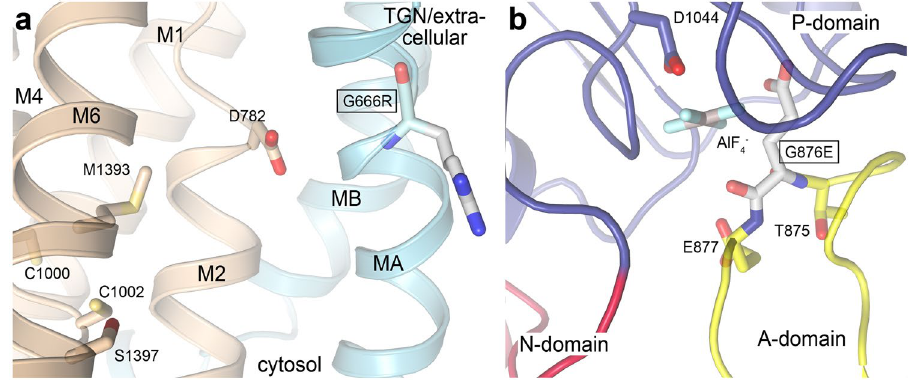
Figure 12. The post-Golgi arrested mutations G666R A and G876E A . The domains of ATP7A are colored as in Fig. 1, and functionally relevant residues shown as sticks using a previously established homology model of ATP7A (6) based on the crystal structure of the homologous protein LpCopA from Legionella pneumophila (2). (A) close-view of G666R at the possible release pathway from the CPC-motif (C1000 and C1002) and via D782 to the non-cytosolic side. The mutation may directly prevent copper passage through sterical hindrance or influence of the local environment at the membrane interface. ( b ) Close-view of G876E at the catalytic Aspartate (D1044). G876 is located in the TGE-loop of the A-domain which is responsible for dephosphorylation (AlF 4 − is a phosphate mimic used for structure determination of LpCopA). The mutation is likely to prevent dephosphorylation and